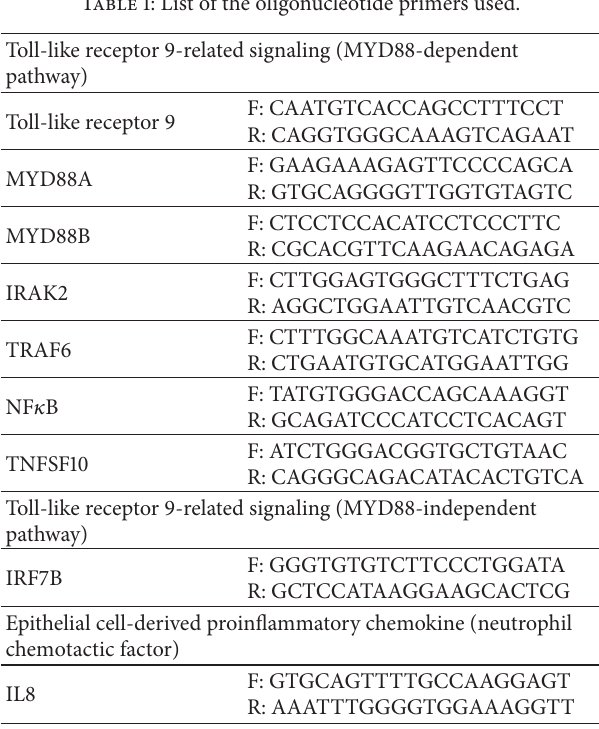
Table 1: List of the oligonucleotide primers